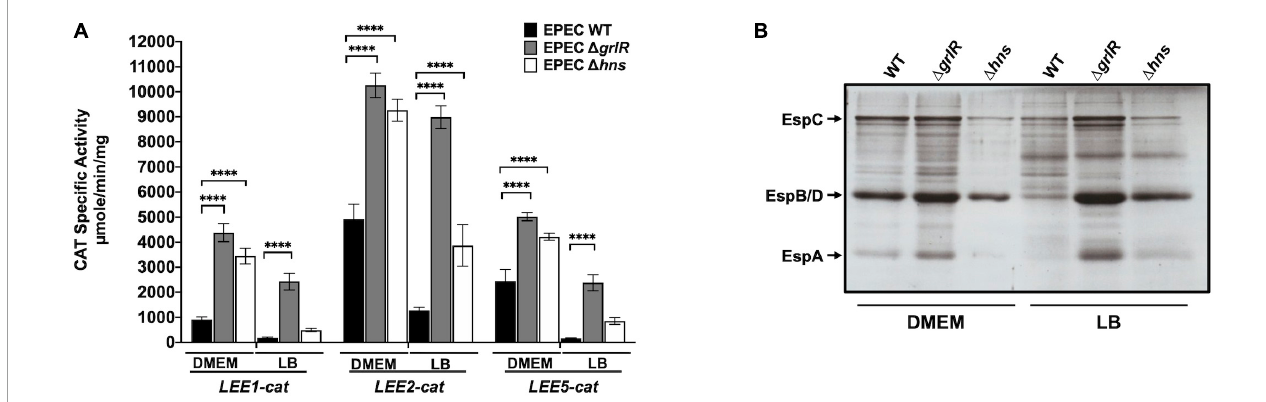
FIGURE3 GrlR is the main repressor of locus of enterocyte effacement (LEE) gene expression under repressing conditions. (A) Expression of the LEE1-cat , LEE2-cat and LEE5-cat fusions was analyzed in WT EPEC (black bars) and its (cid:49) grlR (gray bars) and (cid:49) hns (white bars) isogenic mutants, grown in 50 ml of Dulbecco’s modified Eagle’s medium (DMEM) or Lysogeny Broth (LB) with shaking at 37 ◦ C. Specific chloramphenicol acetyltransferase (CAT) activity was determined from samples collected from cultures at an OD 600 of 1. Values are an average of three independent experiments performed in duplicate. Error bars indicate standard deviations. Statistically different values are indicated ( ∗∗∗∗ p -value < 0.0001). (B) Secreted proteins of the same cultures were concentrated from supernatants by precipitation with trichloroacetic acid (TCA), separated by 12% SDS-PAGE and stained with Coomassie brilliant blue.